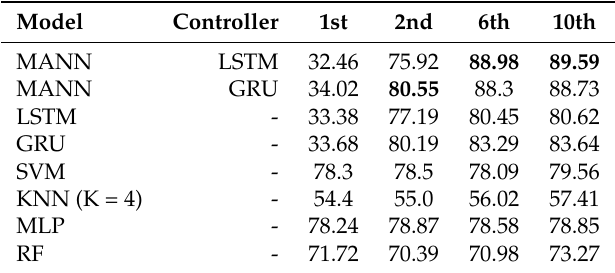
Table 11. In the case of fine-tuning, the previous model is continued to train with eight samples each class of ransomware before classifying the remains ransomware samples in Domain 2